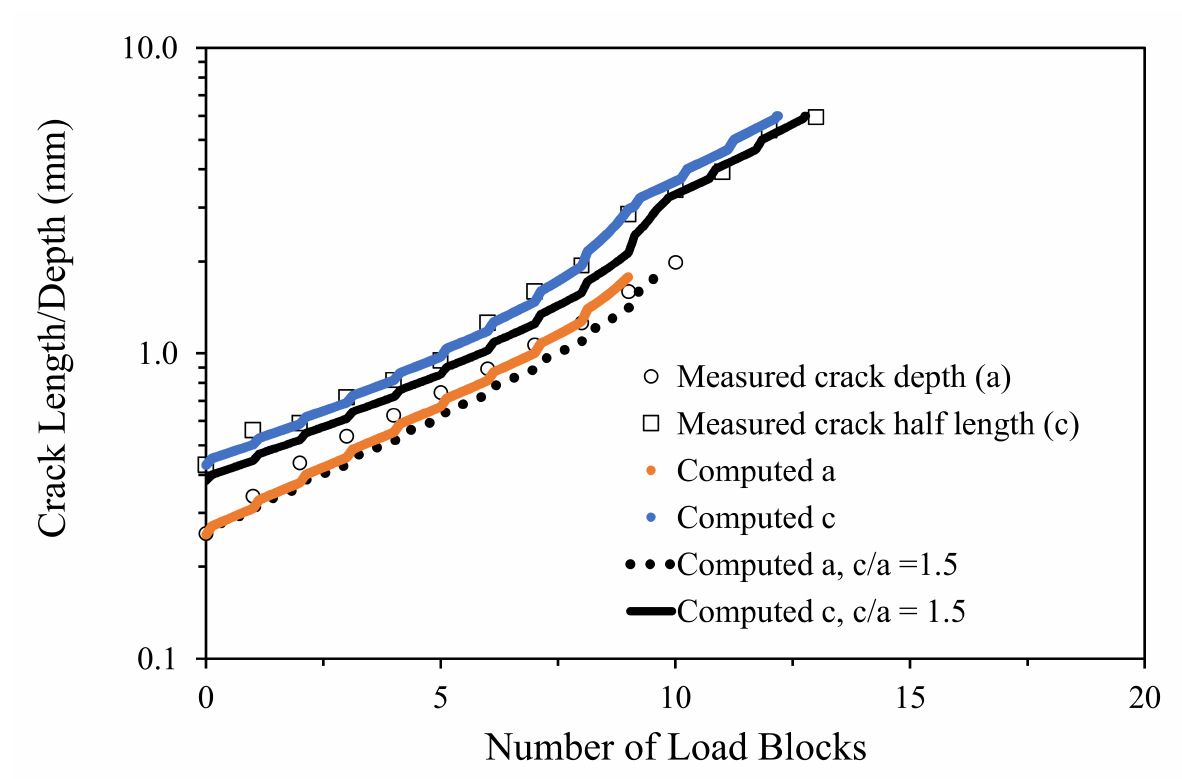
Figure 9. Comparison between measured and computed crack growth